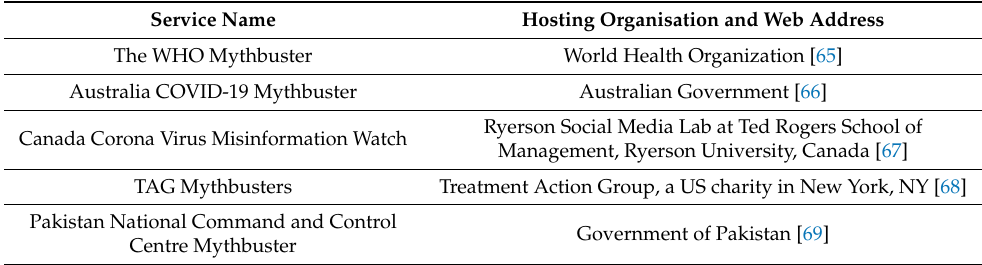
Table 1. Examples of online COVID-19